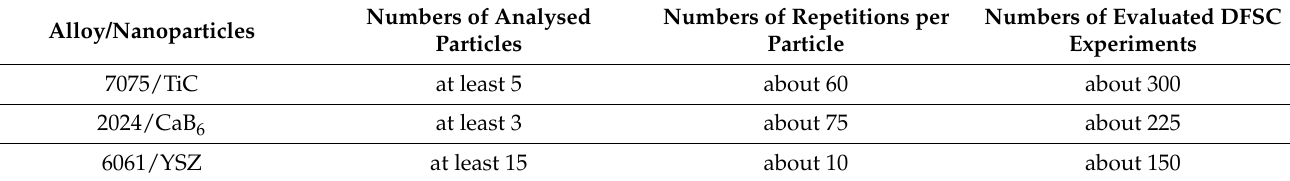
Table 3. Numbers of analysed particles, numbers of repetitions per particle and numbers of evaluated DFSC experiments for each